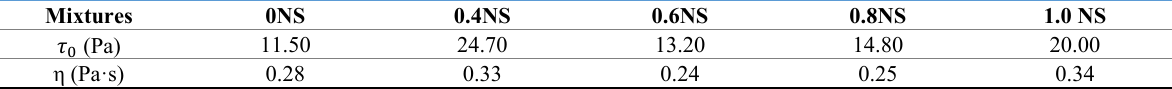
Table 4. Rheological parameters for cement